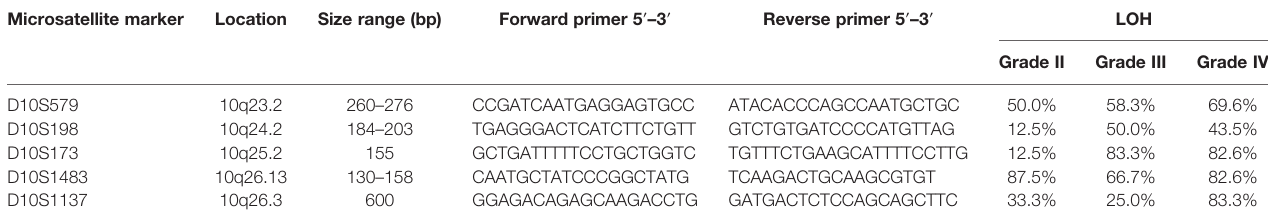
TABLE 2 | Primer sequences and frequencies of LOH at fi ve microsatellite markers.